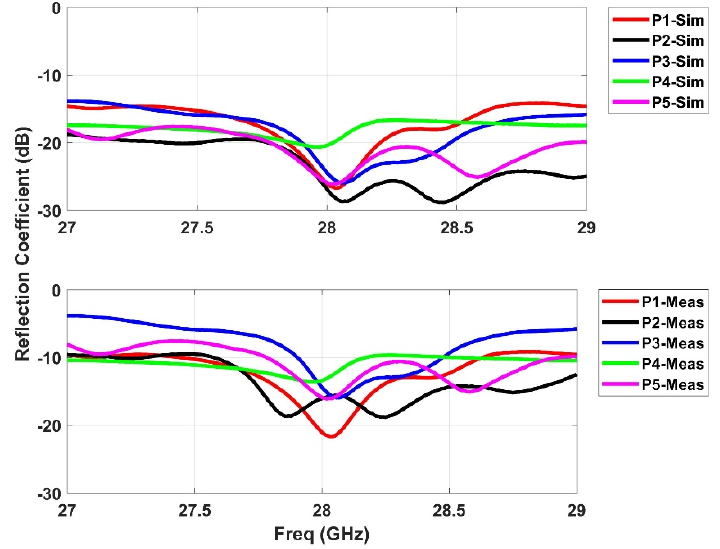
Figure 4. Simulated and measured s-parameters for the beam ports (P1–P5).